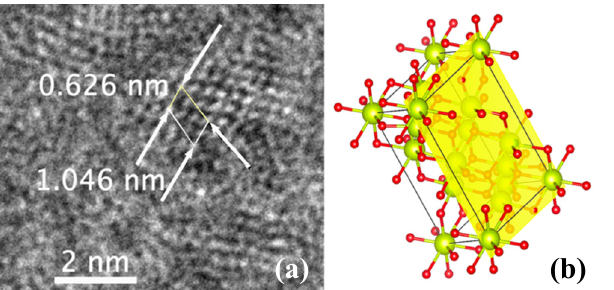
Figure 9. ( a ) TEM image of Ce 11 O 20 nanoceria crystal ( b ) schematics diagram of the unit cell of Ce 11 O 20.